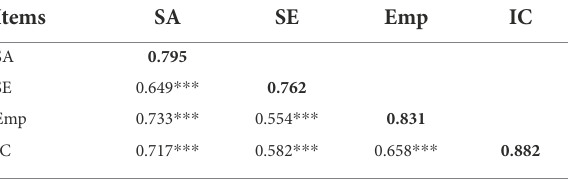
TABLE 3 Discriminate validity of the